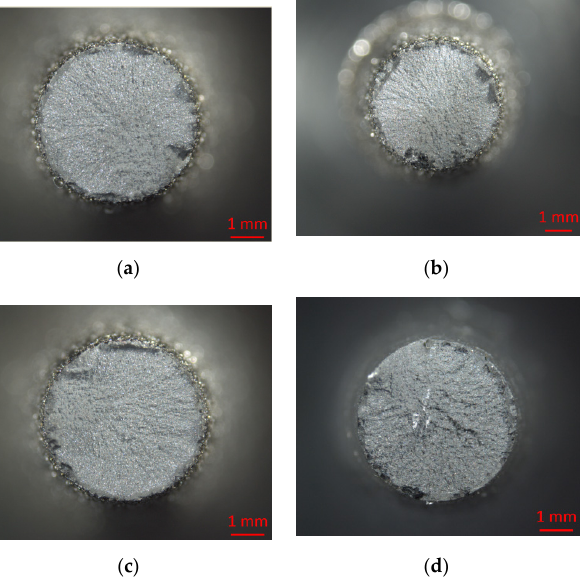
Figure 21. Photographs of the fracture surface of tensile specimens manufactured by: ( a ) EDM (cop- per ET); ( b ) EDM (composite ET); ( c ) EDM (graphite ET); and( d ) turning.